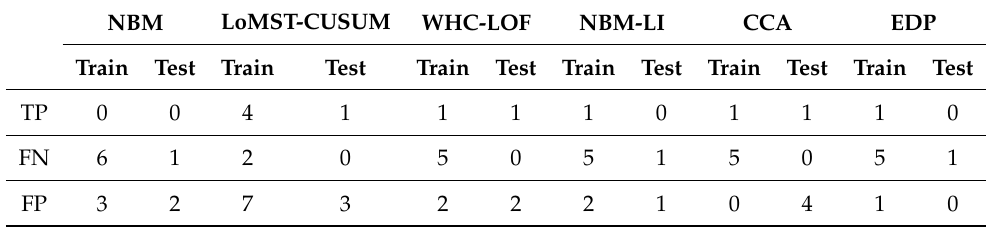
Table 5. Number of each type of predicted fault for each model for the training and test periods.